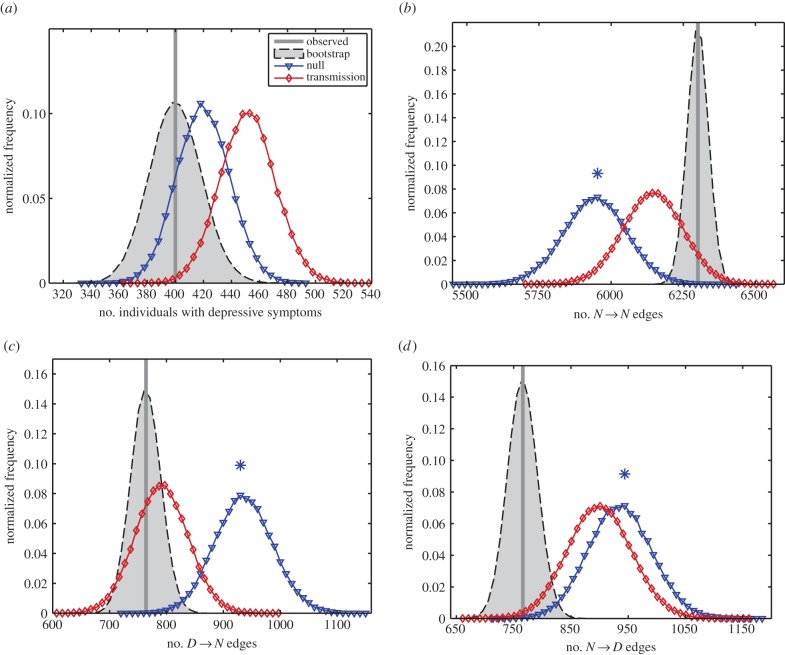
Static summary statistics for the stationary distributions of the models versus real data. Asterisks above a plot denote a significant statistical difference at the 5% level, corresponding to p < 0.01 using the Bonferroni method to account for multiple testing. (a) Prevalence of individuals with depressive symptoms—observed data could be plausibly generated by both transmission (p = 0.058) and no-transmission (p = 0.41) models. (b) Number of N → N edges—observed data could be plausibly generated by the transmission model (p = 0.15) but not by the no-transmission model (p = 0.0014). (c) Number of D → N edges—observed data could be plausibly generated by the transmission model (p = 0.54) but not by the no-transmission model (p = 0.0035). (d) Number of N → D edges—observed data could be plausibly generated by the transmission model (p = 0.027) but not by the no-transmission model (p = 0.0067). The fifth test and plot is for D → D edges (electronic supplementary material, figure S1). See Appendix B for the p-value calculation method, and electronic supplementary material, figure S2, for stratification by number of contacts.